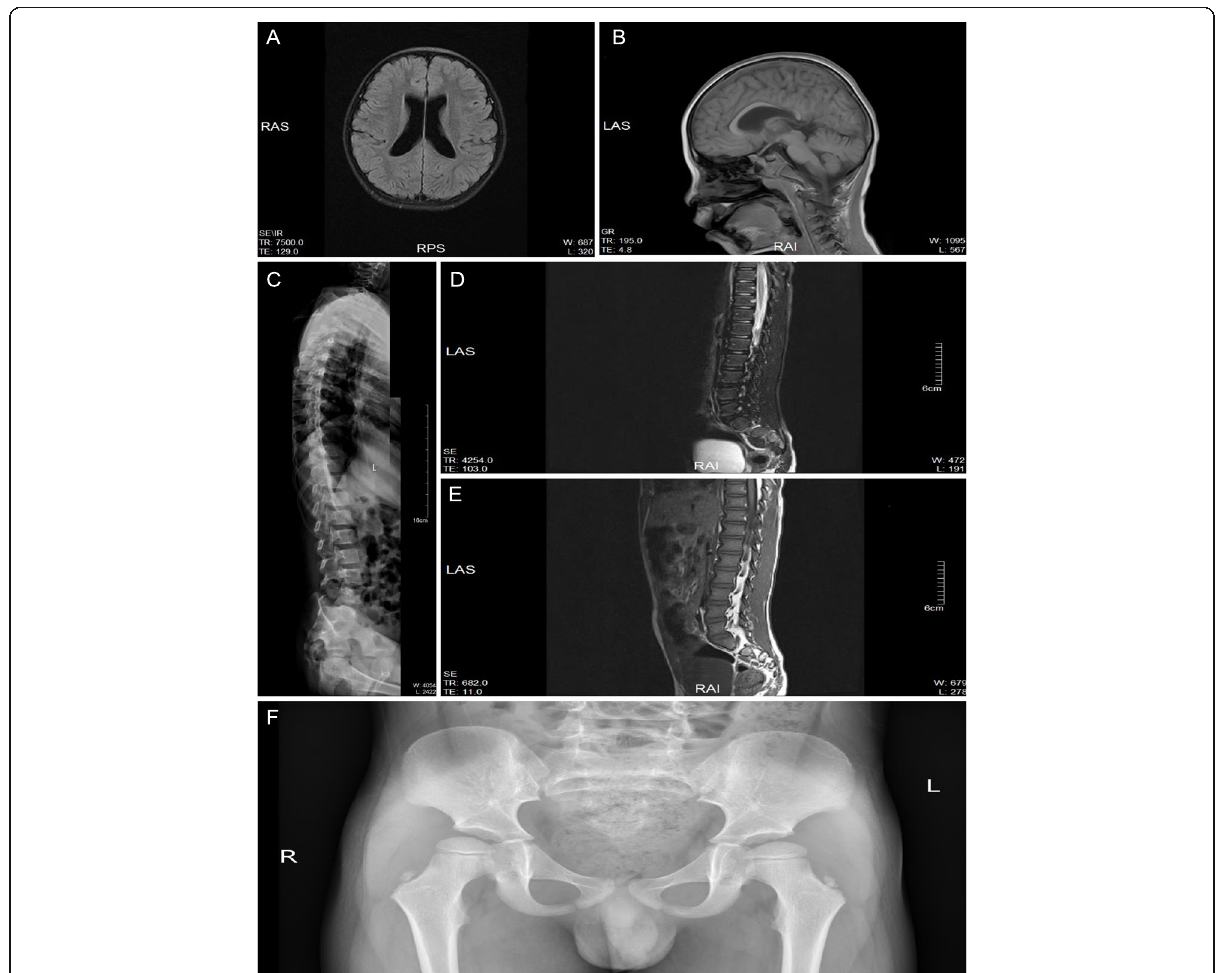
Fig. 1 MRI scan results of patient presented unstable walk with lisping at seven-year-old and was referred to a pediatric neurologist at the 7-year- old (201702). a Brain MRIs showed dilated supratentorial ventricle. b Thin posterior part and splenium of corpus callosum. c Total spine MR imaging suggested 1, L4, 5 recessive spina bifida. d Cervical and thoracic spinal cord scan was normal. e Lumbosacral segment of spinal